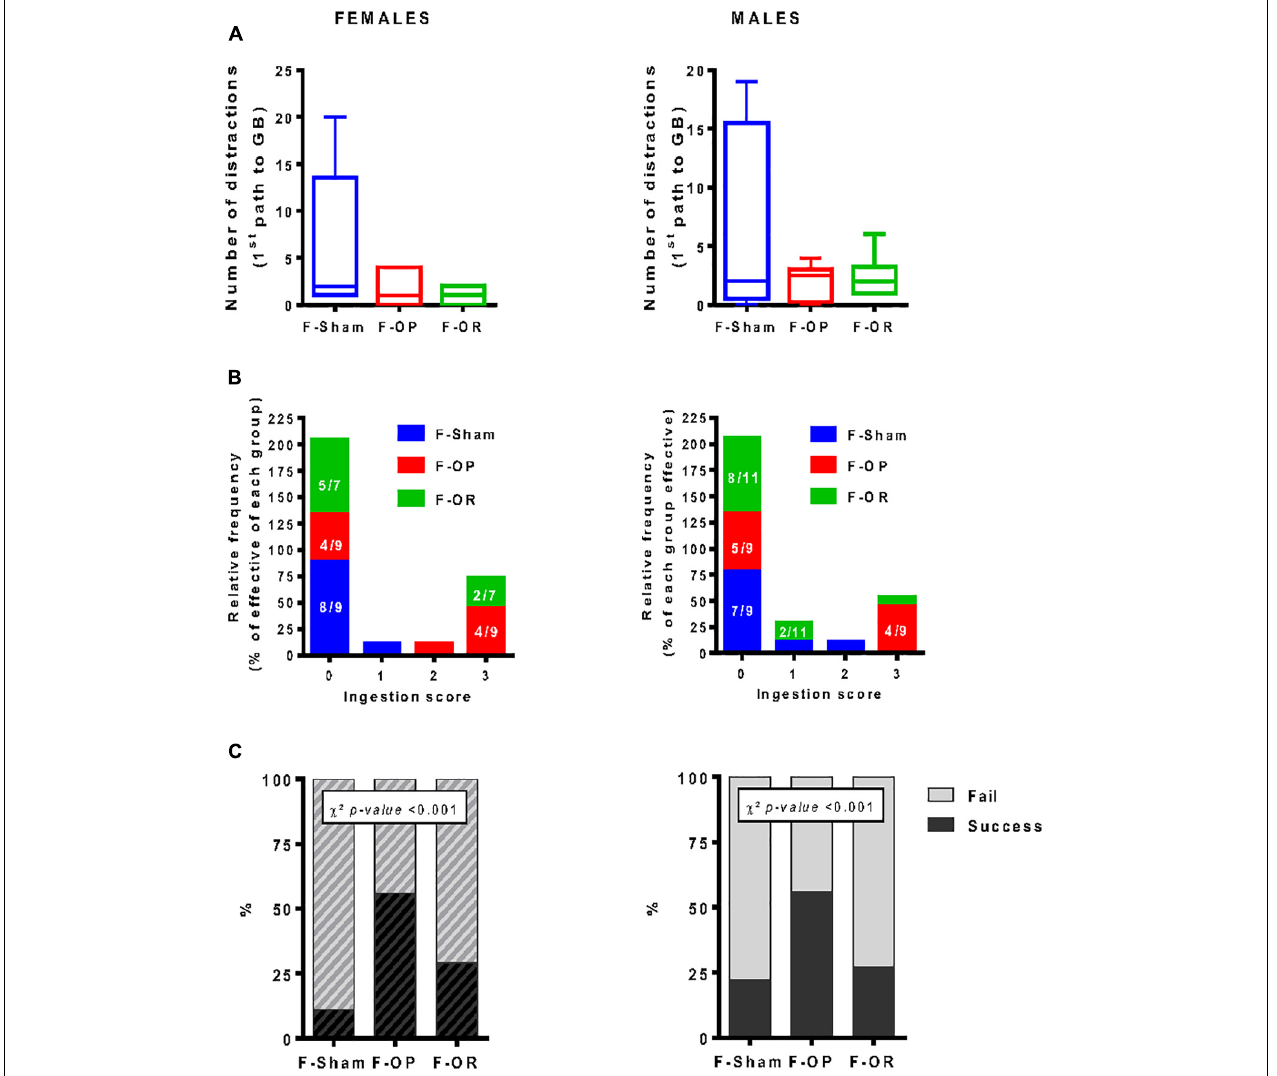
FIGURE 8 | Food motivation (straight alley test). (A) Number of distractions (stops and rearing) during the first walk to food reward, data are medians and min–max, Kruskal–Wallis test. (B) ingestion score (velocity to eat the food reward, scale 0 (lower score) to 3 (higher score), data are number values for each score (frequency). (C) Percentage of test success (eat reward)/failure (not eat reward), uniformity χ 2 test. (A–C) Left: females ( n = 7–9), right: males ( n = 9–11). Animals were 110–125-day old and fed